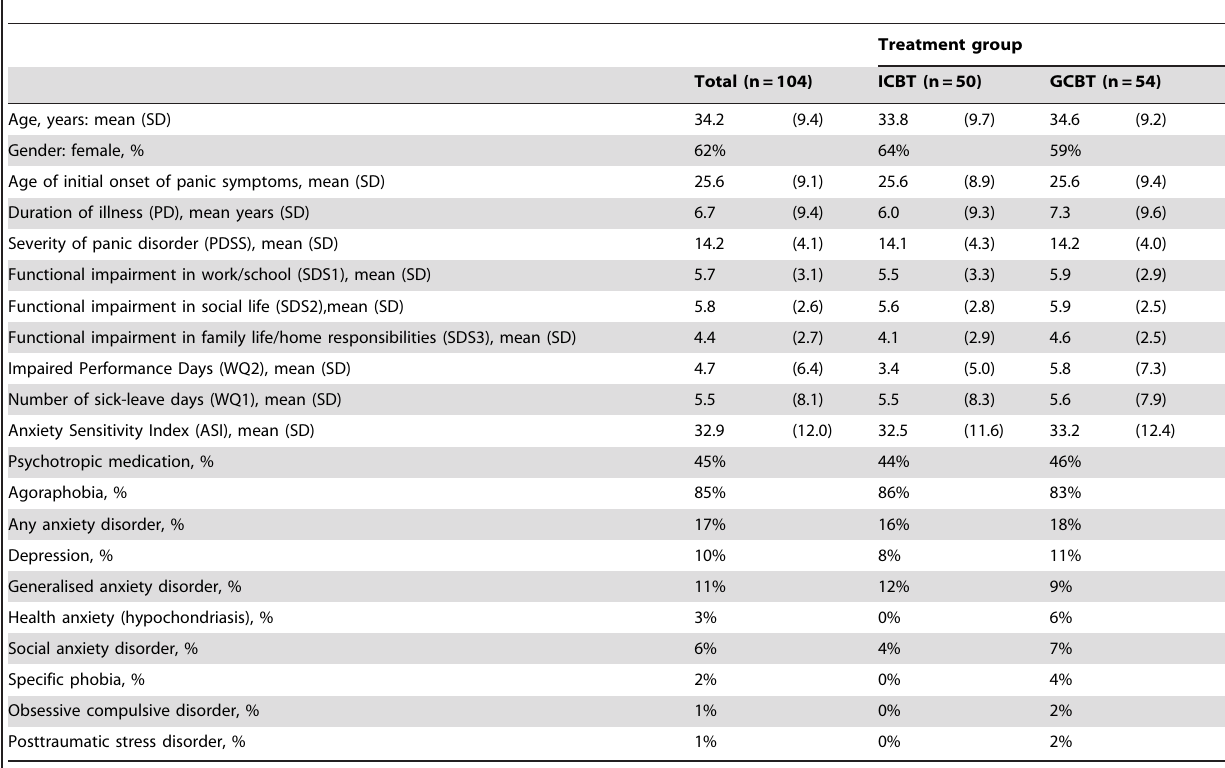
Table 1. Demographic and clinical characteristics of the